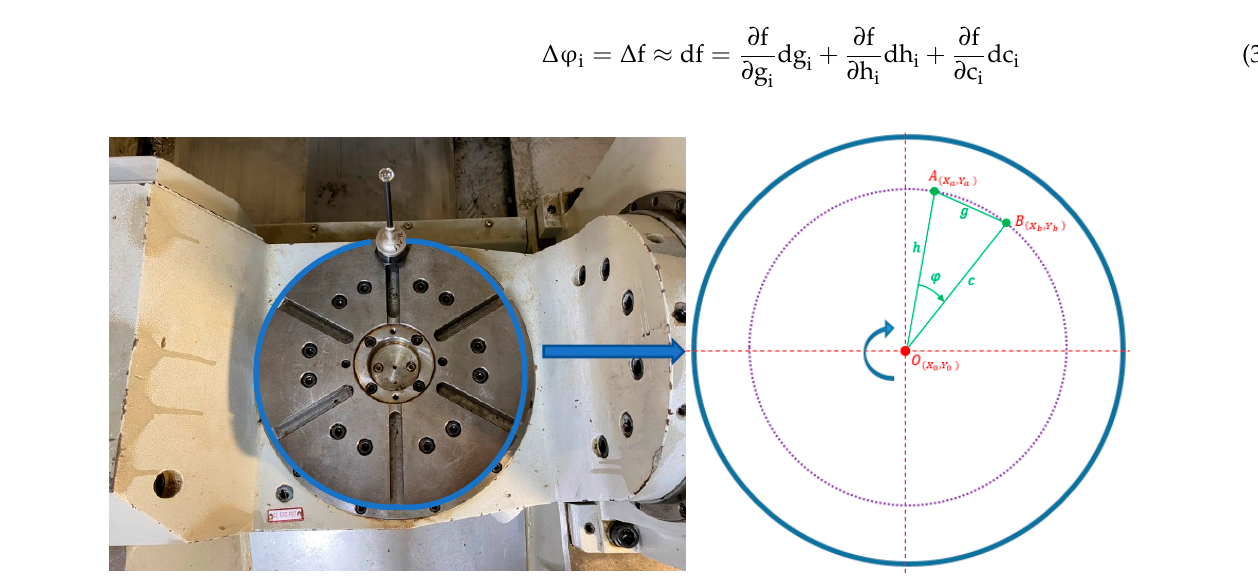
Figure 3. Uncertainty analysis.